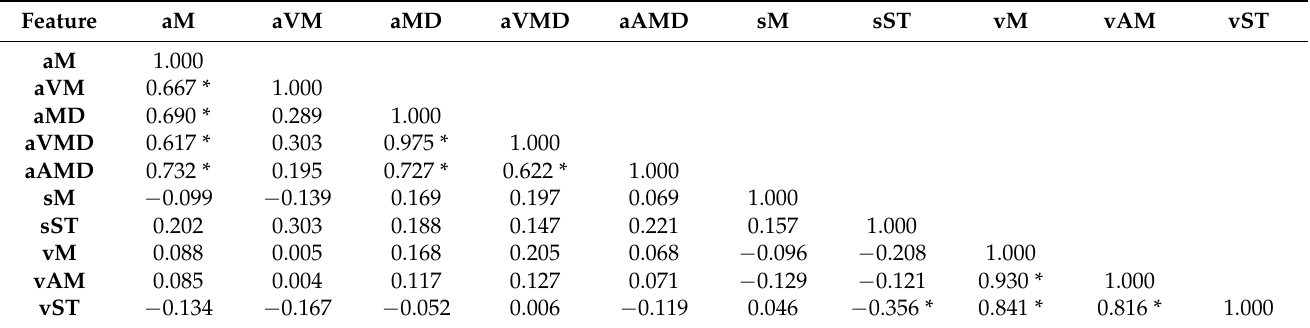
Table 3. Correlation matrix of the top 10 features for the foot (* p -value < 0.05).